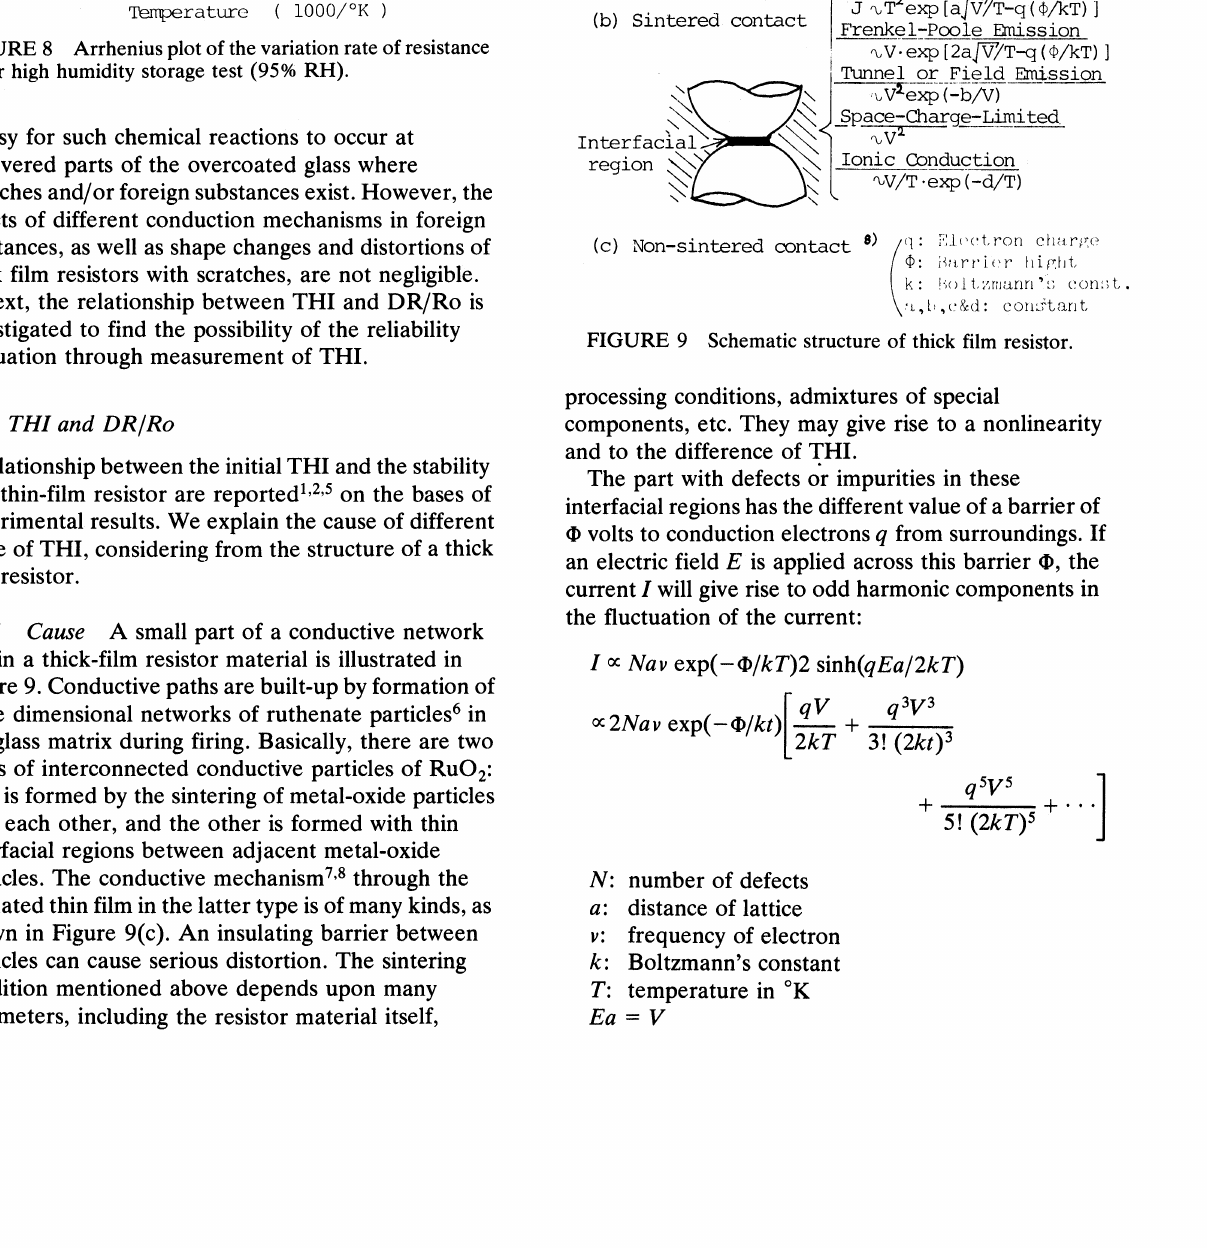
FIGURE 8 Arrhenius plot of the variation rate of resistance under high humidity storage test (95% RH). is easy for such chemical reactions to occur at